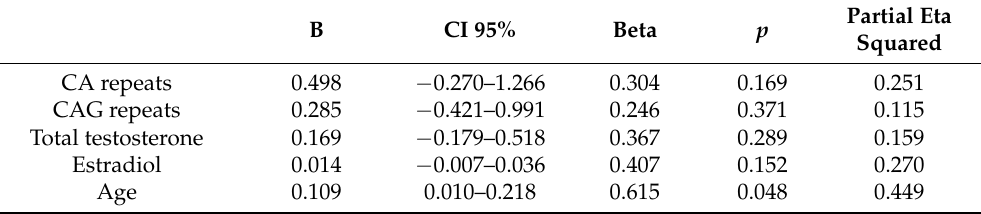
Partial Eta Squared